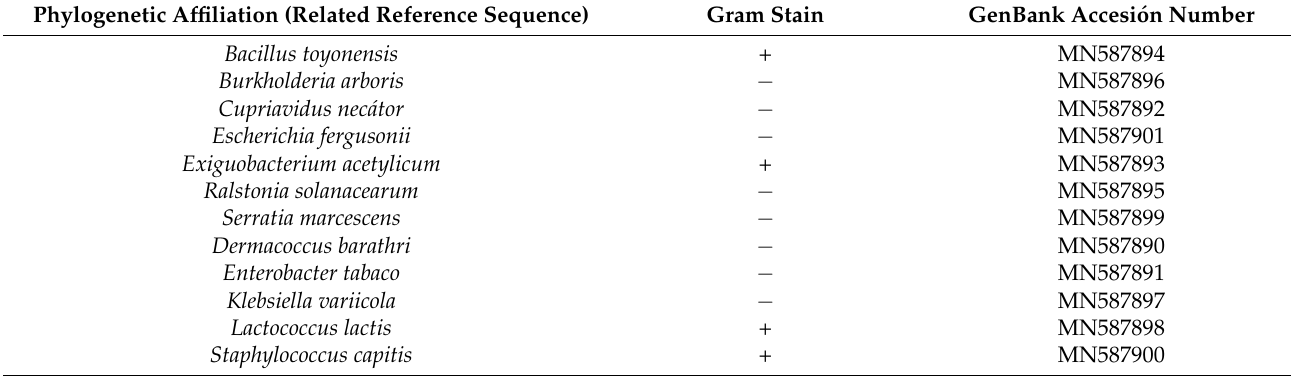
Table 1. Homology of the 16S rDNA sequences of the native cadmium-tolerant soil bacteria. Phylogenetic Affiliation (Related Reference Sequence) Gram